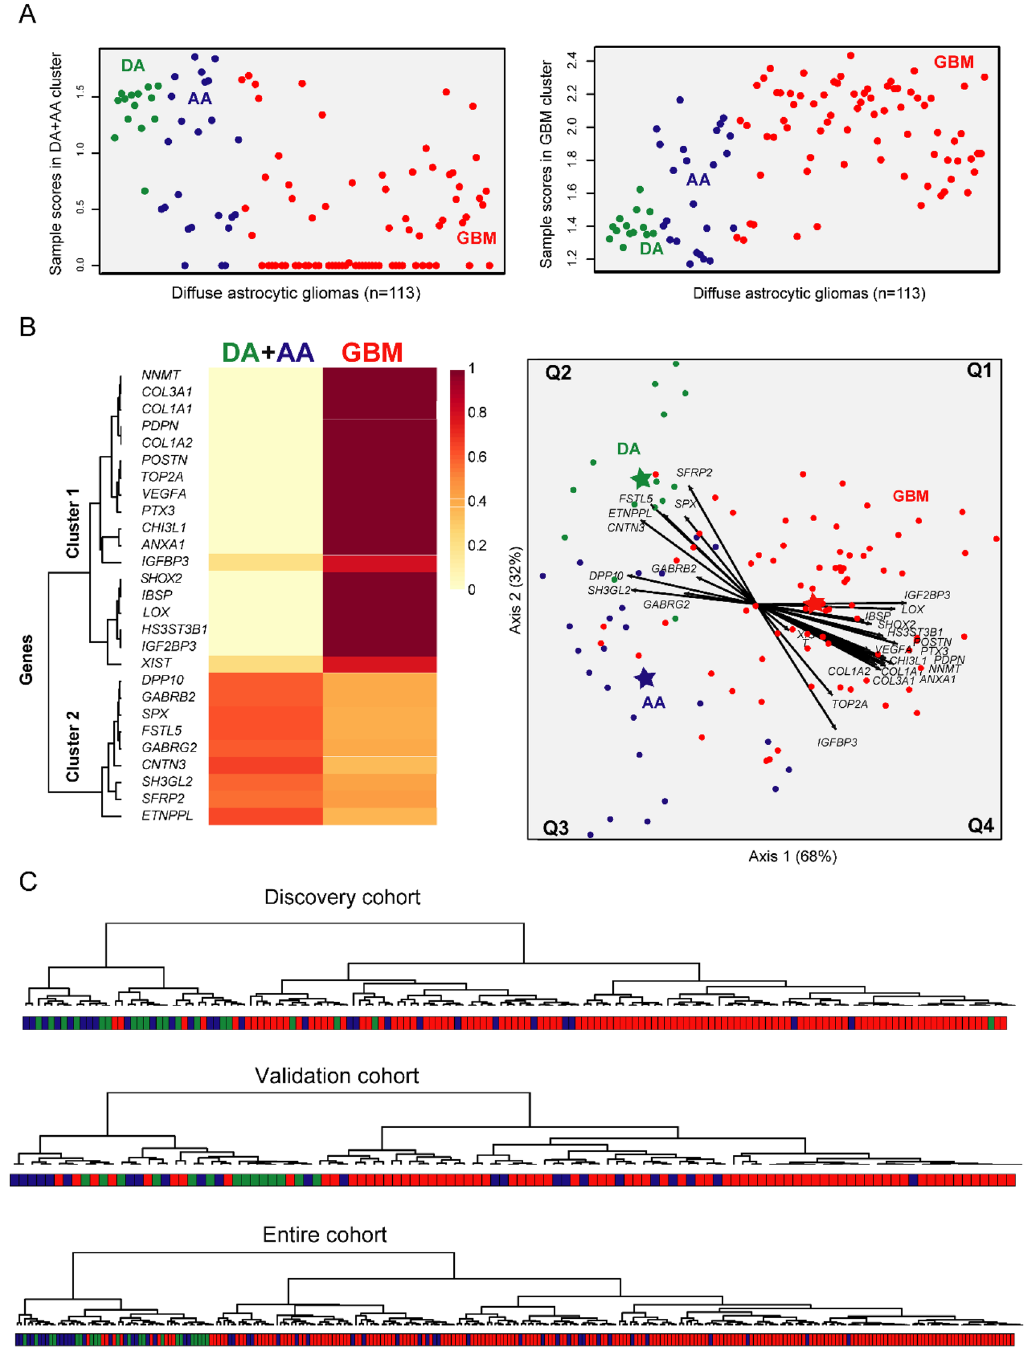
Figure 3. Multivariate analysis of the association between the 27 genes found to discriminate among different histopathological subtypes of diffuse gliomas in the validation set of 113 diffuse astrocytic gliomas. Nonnegative matrix factorization plots of contribution scores of each sample to the formation of each cluster ( A ) and the importance of each gene to the two clusters formed ( B , left) are shown together with canonical biplot ( B, right), that confirmed classification of diffuse astrocytic gliomas around two leading molecular groups: a group including mostly GBM tumors and another group mostly composed of both DA and AA tumors. Dendrograms obtained via non-hierarchical NMF clustering for each (discovery, validation and total cohort) sample are shown in panel C. For the distinction of sample scores in panel A see legend to Fig. 2 . R software for statistical computing and graphics (v3.5.2) was used. DA, diffuse astrocytoma; AA, anaplastic astrocytoma; GBM,